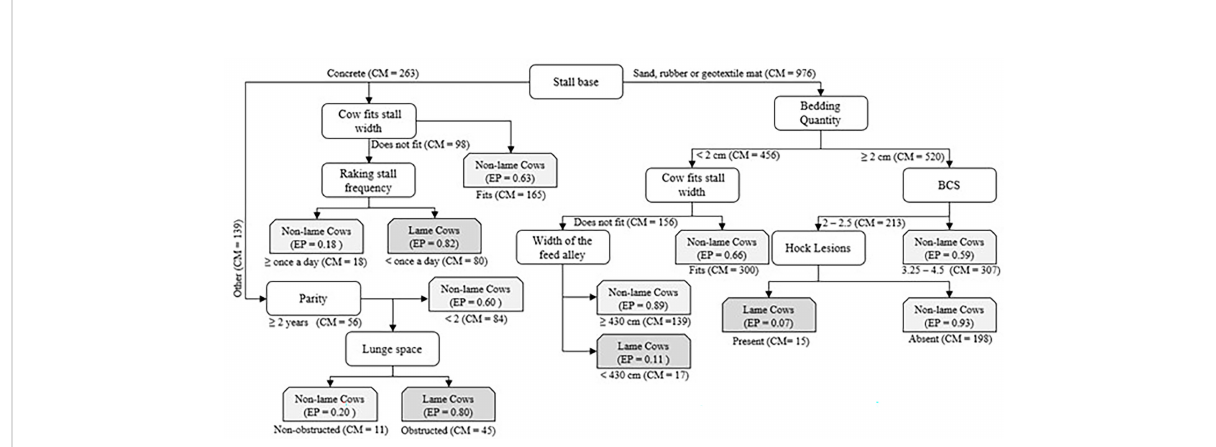
FIGURE 1 Decision-tree model for the incidence of lameness and associated cow- and farm-level measurements for 1,378 cows from 39 pens across 36 farms. Input variables or root and leaf nodes are presented in horizontal rectangles beside the corresponding cut-off value. The decision tree classi fi ed each cow into one category of the lameness output variable, with a cow being either “ lame ” (gray) or “ non-lame ” (light gray). Lameness output variables are shown in snipped corner-rectangles containing the corresponding estimated probabilities for each category. Class membership (the number of records per category of input variables) are shown beside the cut-off point, either above or below nodes as space